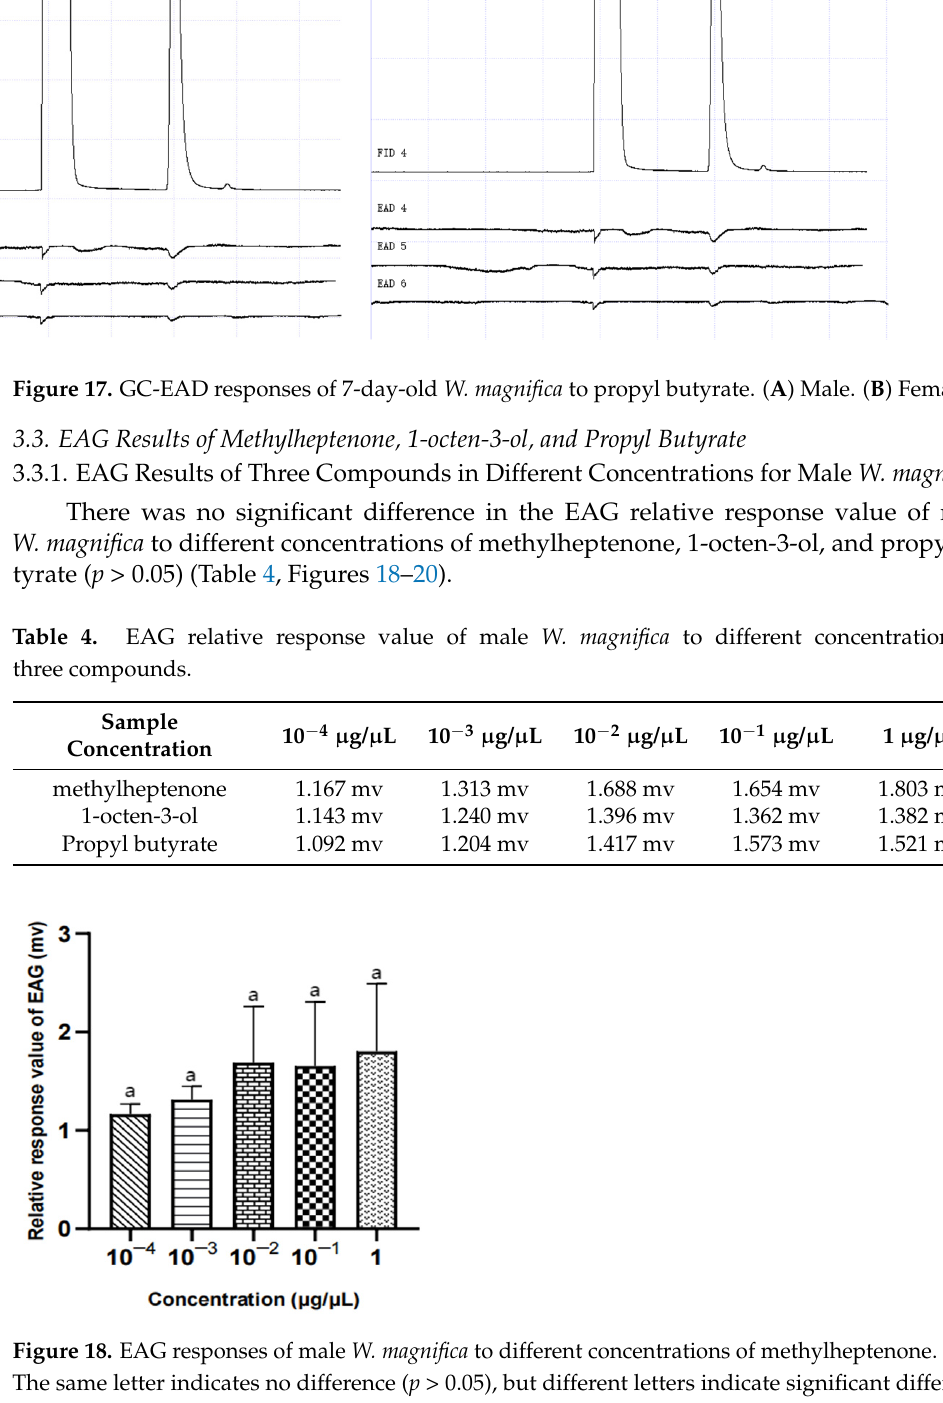
Figure 17. GC-EAD responses of 7-day-old W. magnifica to propyl butyrate. ( A ) Male. ( B ) Female.